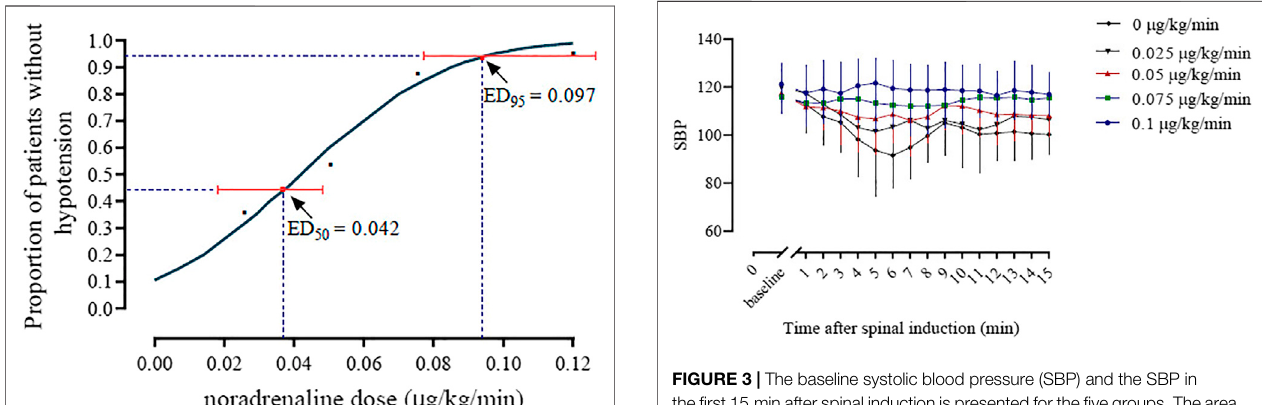
Figure 3 . The areas under the curve were 2,309 ± 33, 2,067 ± 34,